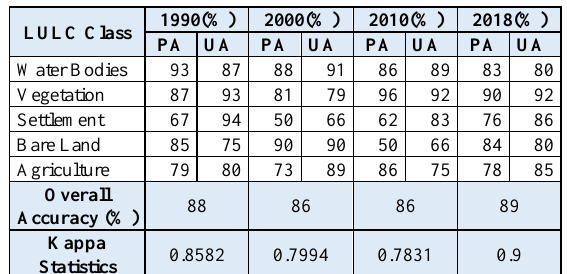
Table 2: Error matrix showing the accuracy assessment of LULC prepared for different